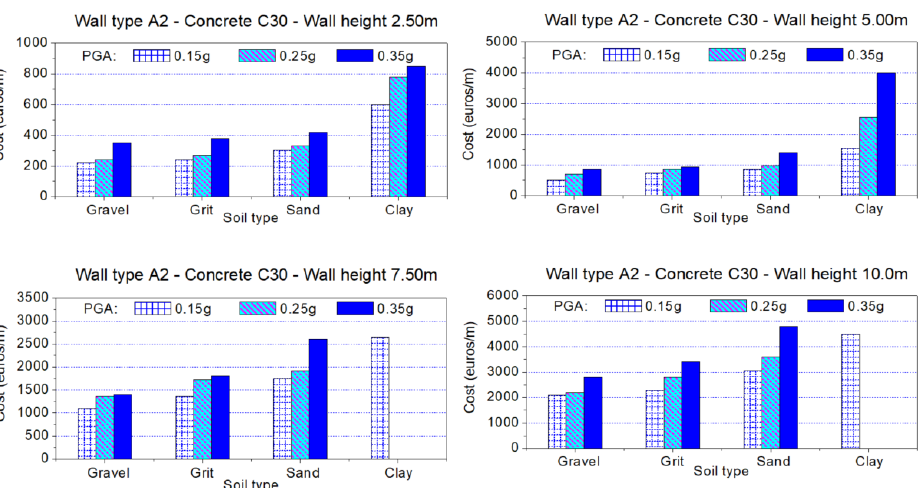
Figure 7. Cost of retaining walls type A2 made by reinforced concrete C30.